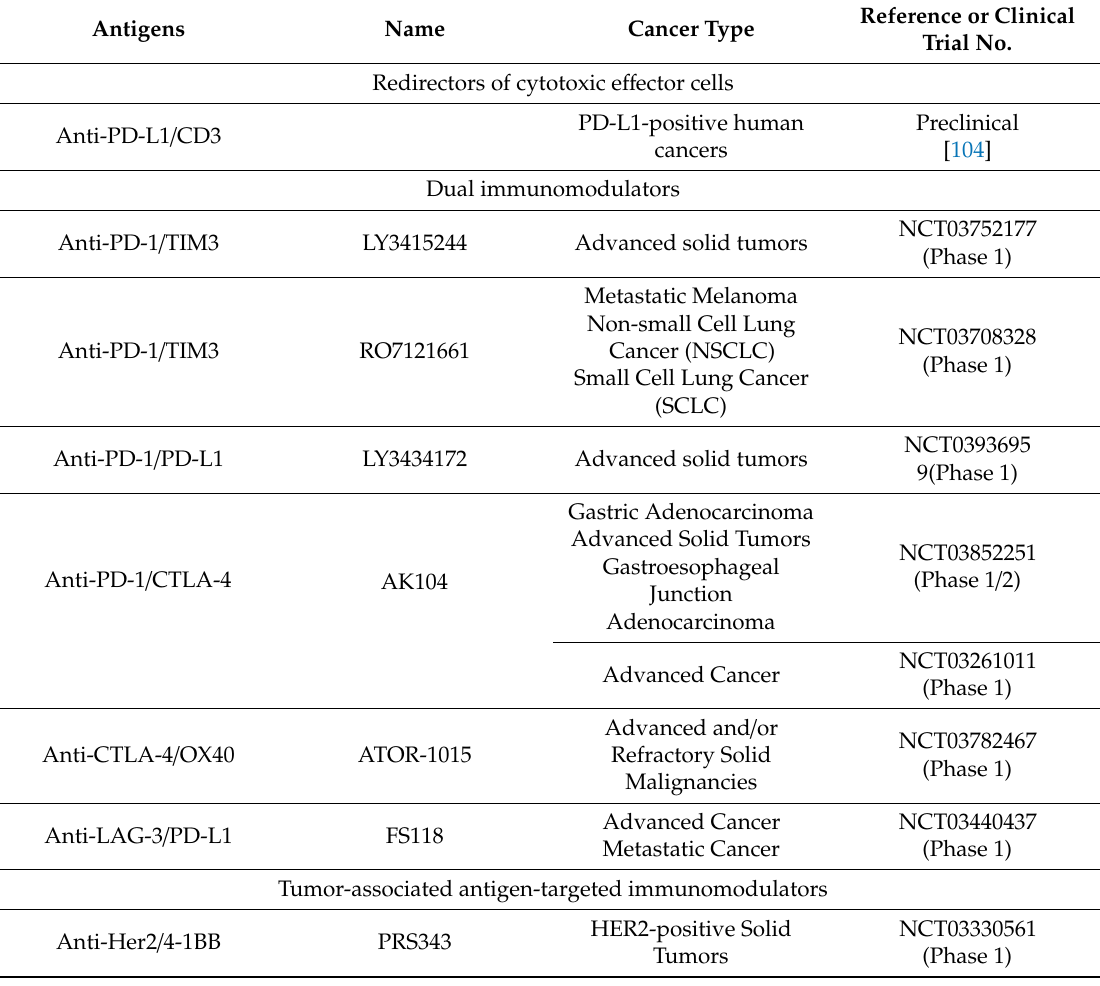
Table 4. Examples of bispecific antibodies targeted against immune checkpoint